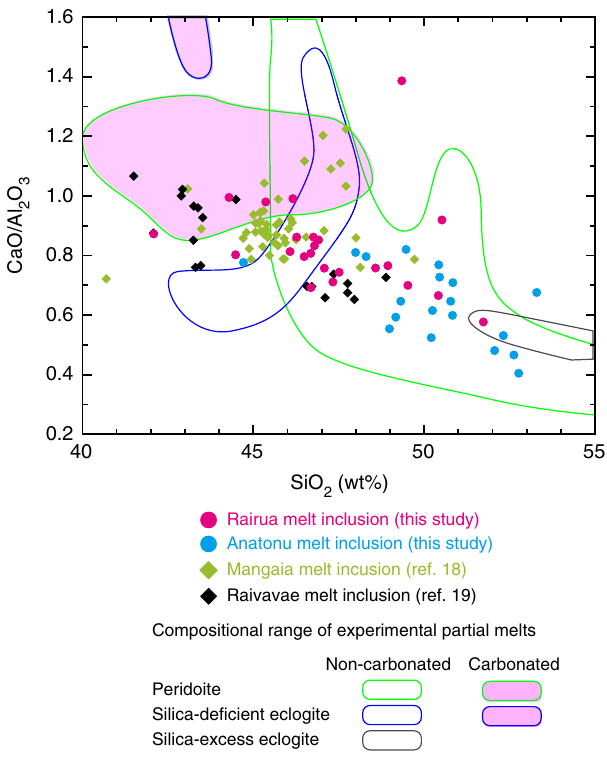
Fig. 3 SiO 2 versus CaO/Al 2 O 3 of melt inclusions. Symbols for melt inclusions are the same as in Fig. 1. Raivavae inclusions without Pb isotope data from previous studies are indicated by black symbols 19 . The compositional range of experimental partial melts of peridotite, silica- de fi cient eclogite and silica-excess eclogite are indicated by the fi elds outlined by green, blue and grey lines, respectively. Experimental partial melts from carbonated sources are shown by purple fi elds 24, 31 –